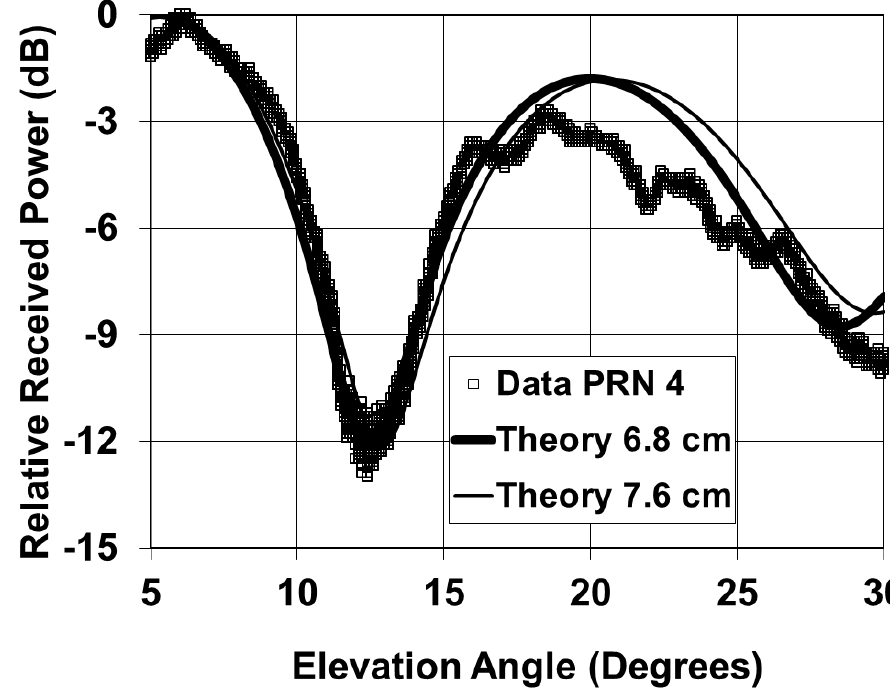
Figure 4. (Lines) Theoretical and (square) measured elevation plots for a ground reflector covered by 6.8- and 7.6-cm-thick snow layers with h = 45.1 cm for the GPS satellite PRN 4. The values ε = 1.60 – i 3.58 × 10 −4 and ε = 1.48 – i 2.76 × 10 −4 are used in the snow snow 6.8- and 7.6-cm-thick snow layer models, respectively. The GPS times from the measurements are 14:44 to